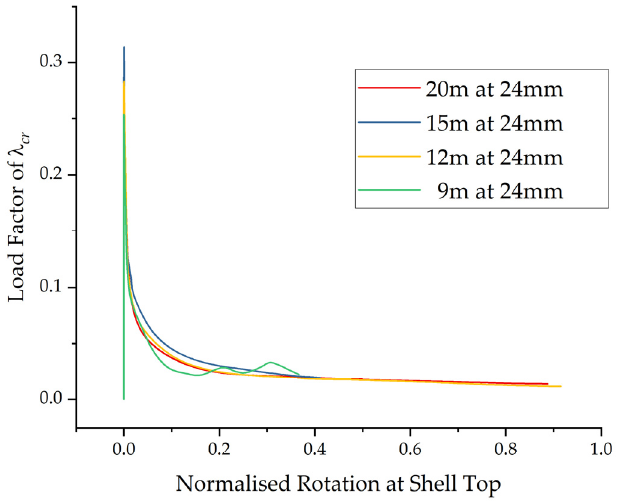
Figure 26. Load-rotation curves of 4 shell models of 24 mm thickness in different lengths.